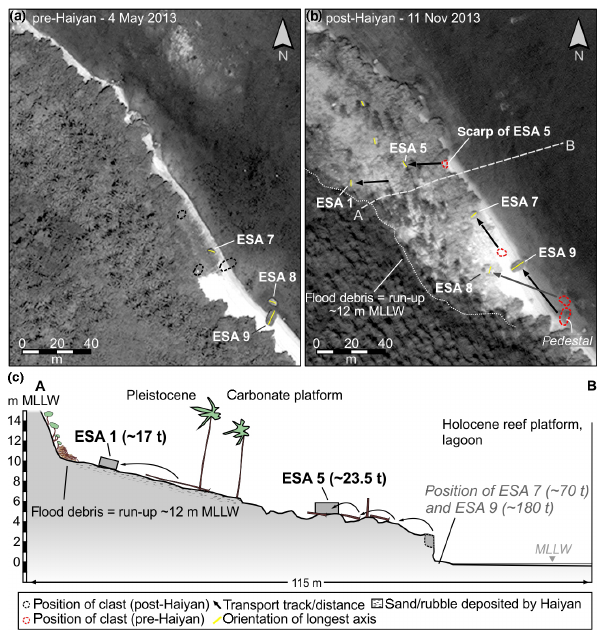
Figure 3. Large clasts transported by Haiyan at site ESA. (a, b) Pre- (WV1, 4 May 2013) and post-Haiyan images (WV2, 11 November 2013) illustrating run-up extent; position of clasts ESA 1, 5, 7, 8, and 9; and trajectories. Transport direction of largest clasts ESA 7 and 9 is SE–NW, documenting a NW-directed surge. ESA 9 was moved by ∼ 40m. (c) Transect A–B. Flood debris at 12m MLLW indicates maximum run-up. ESA 5: quarried from cliff